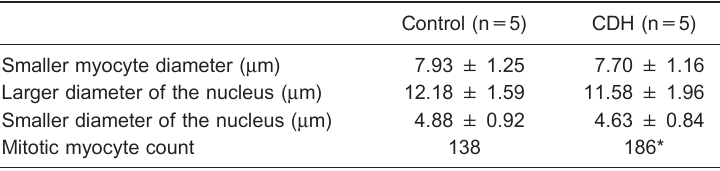
Table 3. Histological data of control and congenital diaphragmatic hernia (CDH) groups.